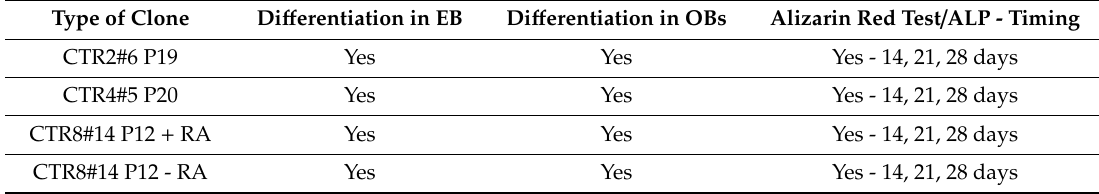
Table 1. Number and types of clones used for in vitro tests of the protocol. Type of di ff erentiation (embryoid bodies (EB), or Ooteoblasts (OBs)) were reported, so as alizarin red and alkaline phosphatase (ALP) analysis and